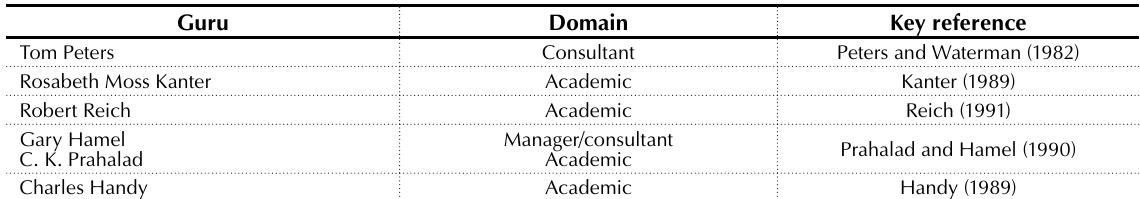
Table 1. Influential management gurus involved in legitimizing and popularizing outsourcing in the early